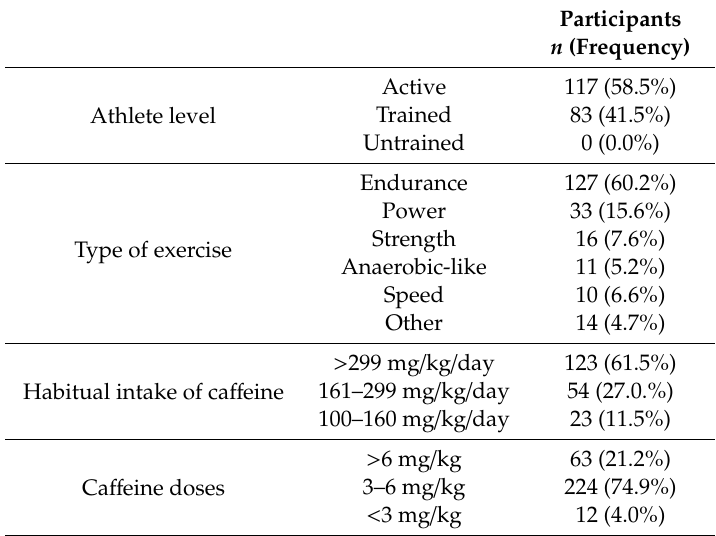
Table 1. Number of participants in investigations aimed at determining the ergogenic e ff ects of ca ff eine in habitual groups, depending on dose, habitual intake, type of exercise and participant’s fitness